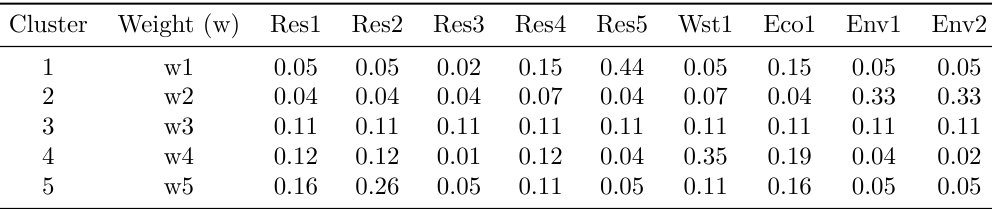
Table 4. Indicator weights for each cluster.